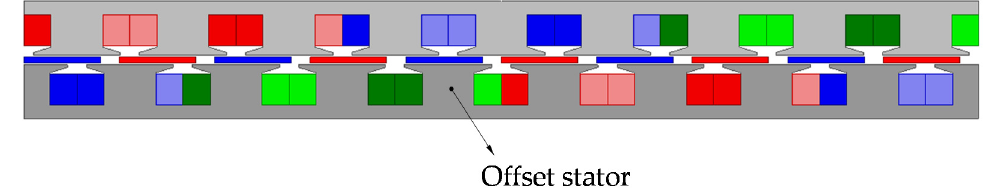
Figure 2. Proposed double-sided offset stator single-rotor (DOSSR) AFPM motor in 2D. Table 1. 9-slot 8/10-pole concentrated winding connection.